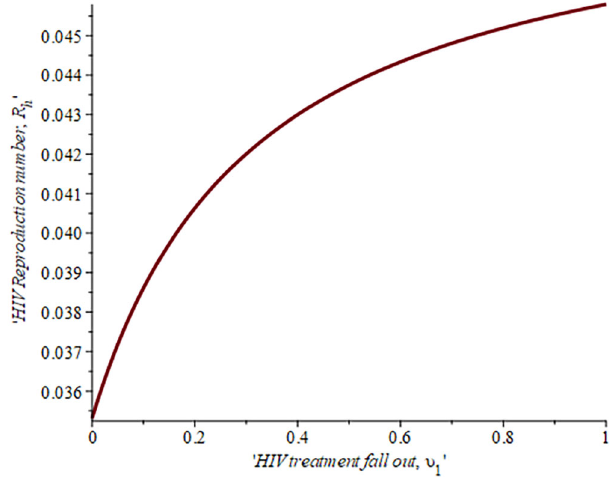
Þ by choosing different initial